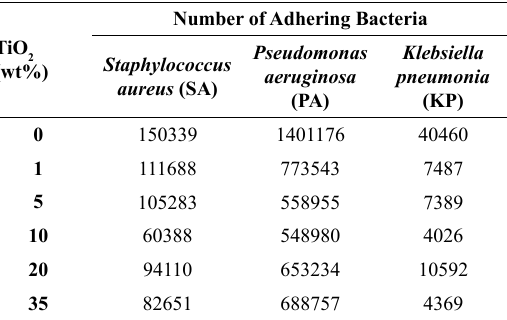
/ABS composites 2